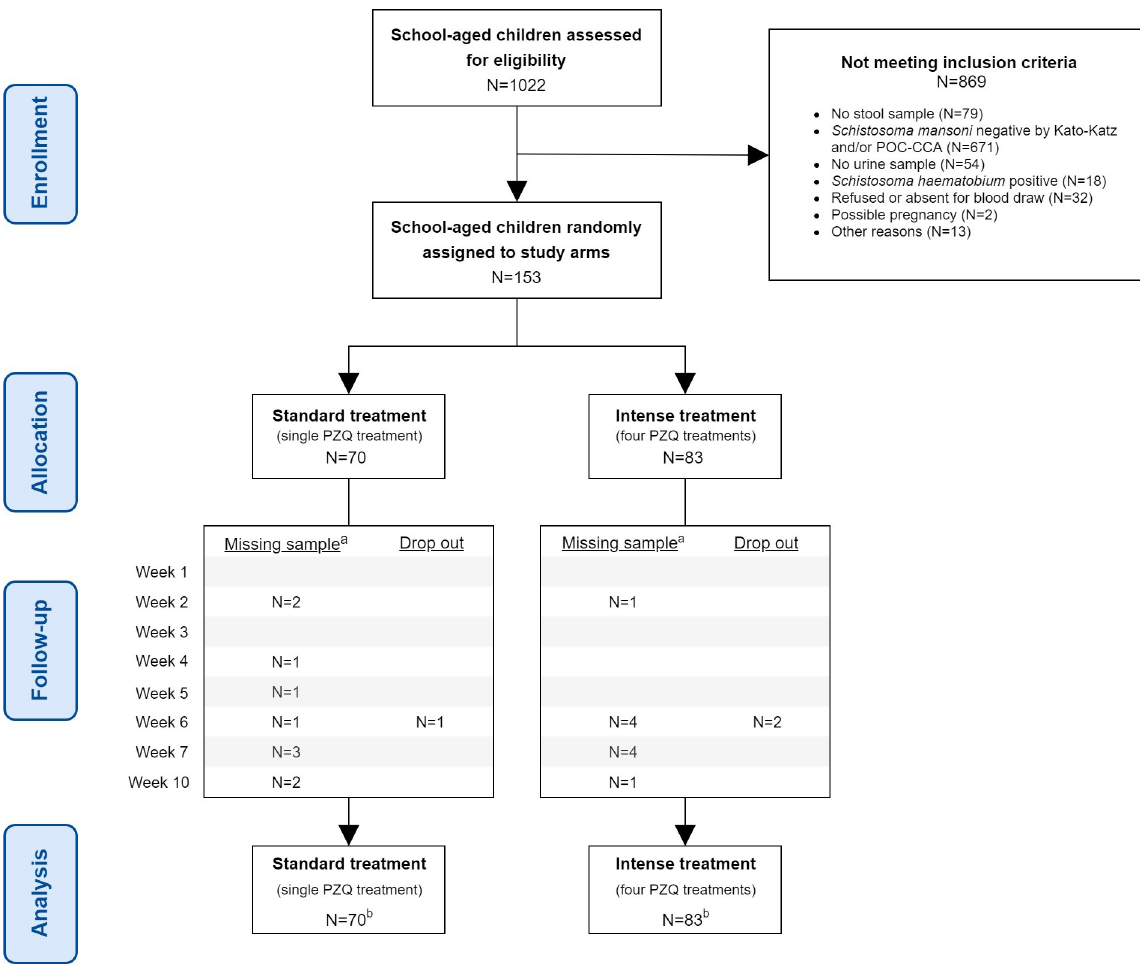
Fig 1. Trial profile. a. Sample (urine and/or stool) not provided. b. Intention-to-treat analysis.